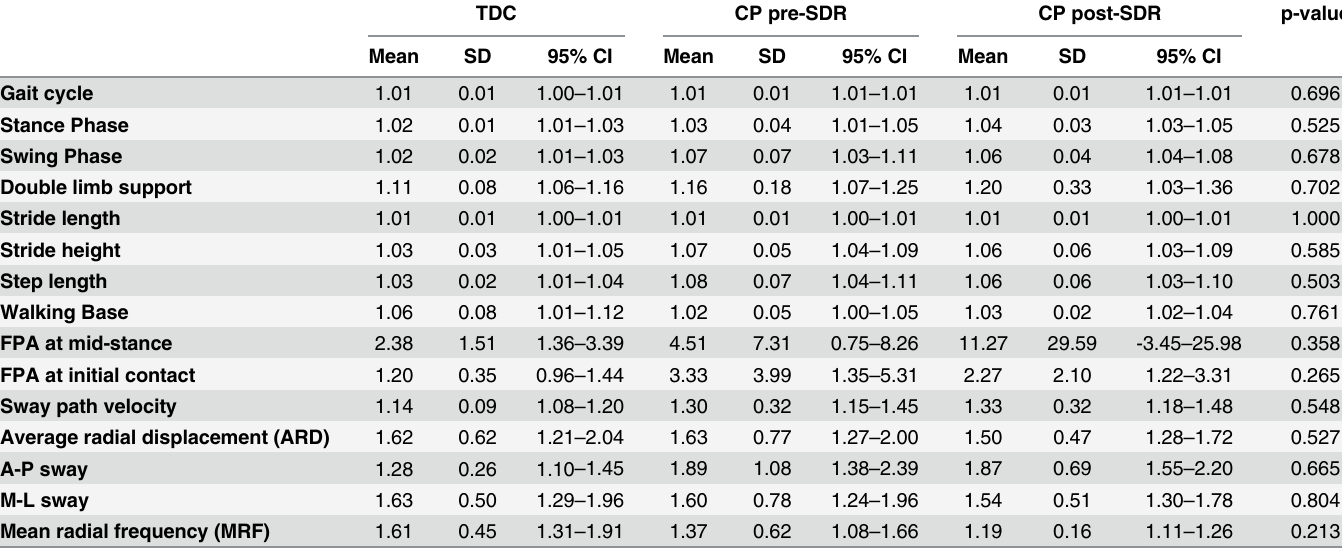
Table 3. Symmetry ratio of spatiotemporal and postural balance